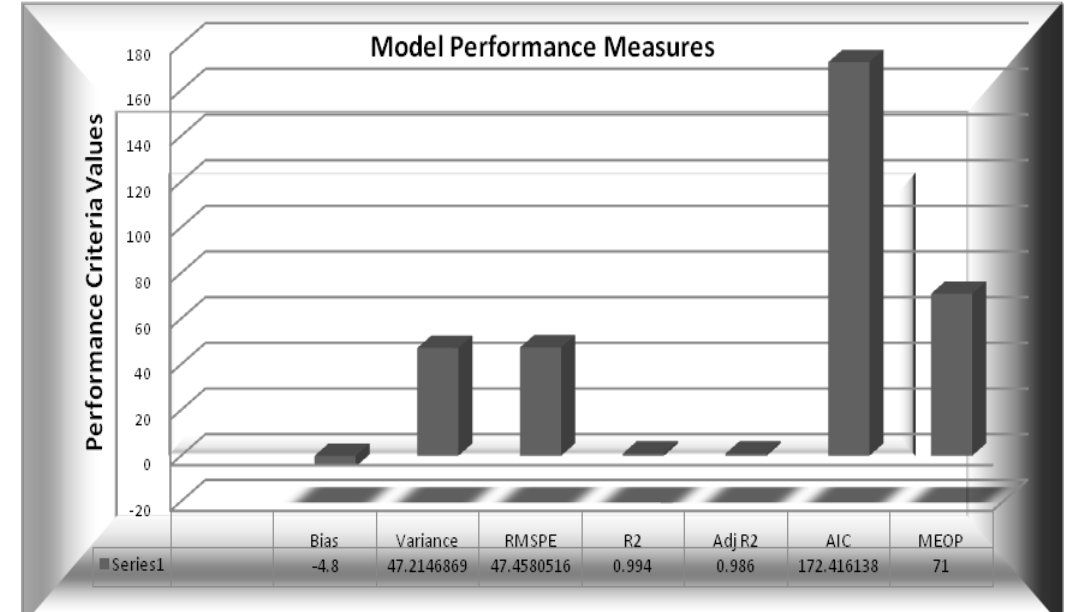
Fig. 3. Model performance